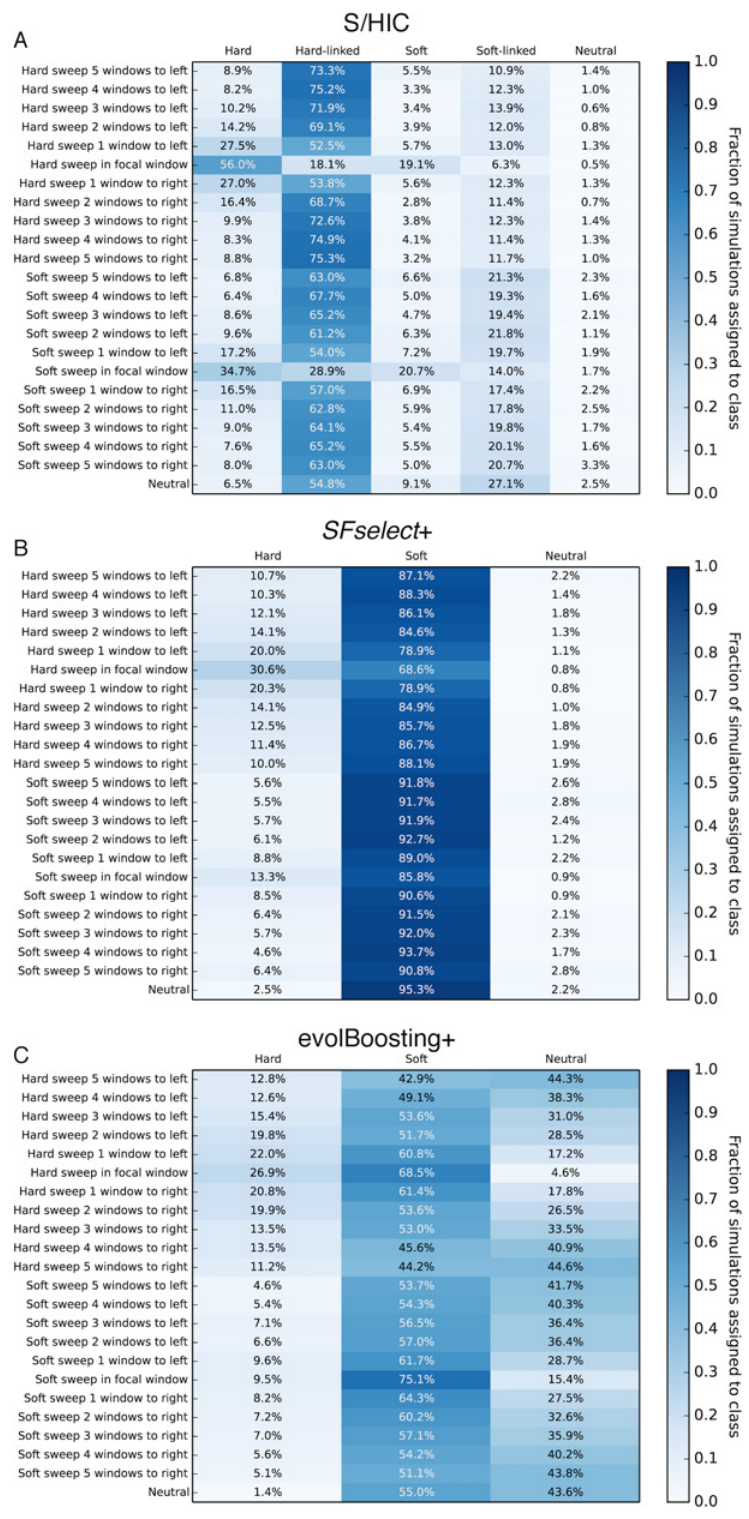
Fig 7. Heatmaps showing the fraction of regions simulated under Tennessen et al. ’ s European demographic model located at varying distances from sweeps inferred to belong to each class by S/ HIC, SFselect +, and evolBoosting+. The location of any sweep relative to the classified window